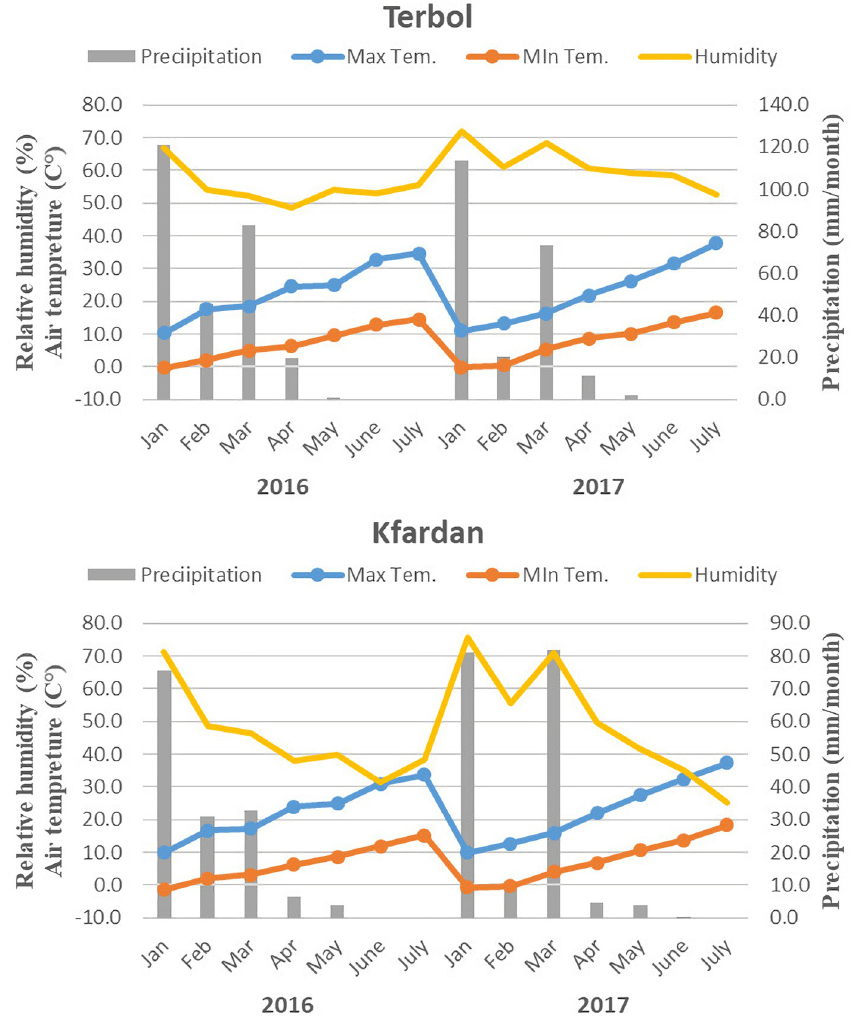
Fig 1. Monthly total precipitation. Maximum and minimum mean air temperature and relative humidity for Terbol and Kfardan stations in 2016, and 2017 seasons.